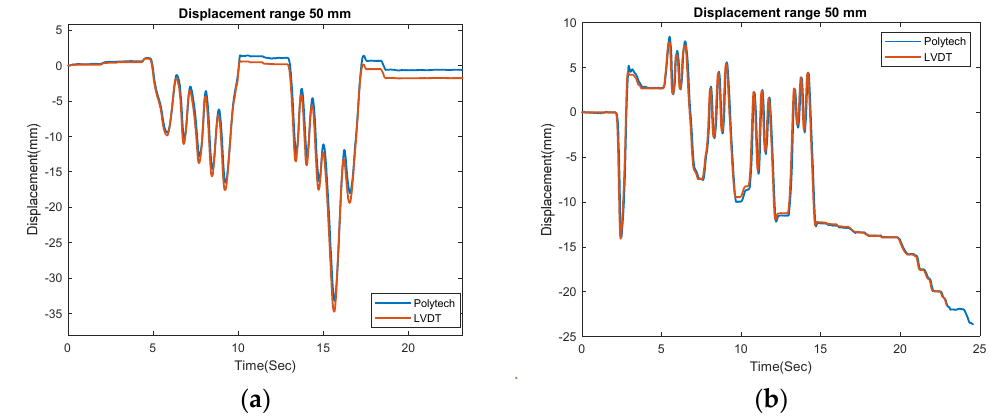
Figure 4. Ground base laser and LVDT measurement of a moving target; ( a ) at 26 m; ( b ) at 55 m.